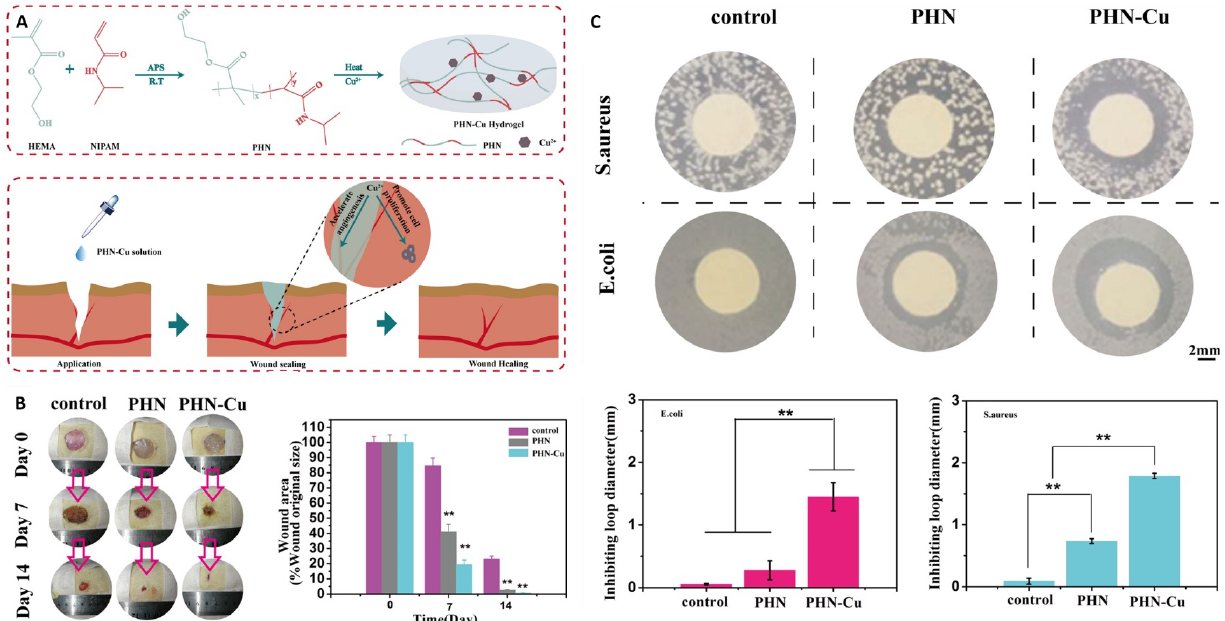
Figure 2. A schematic showing the preparation of thermosensitive polymer followed by wound healing ( A ); the in vivo results of different samples when they were applied on the wounds for 14 days ( B ); the antibacterial activity of samples against both Staphylococcus aureus and Escherichia coli bacteria ( C ); ammonium persulfate (APS), radical transformation (RT), poly-(HEMA-co-NIPAM) (PHN), reprinted from [11] with permission from Wiley. ** denotes p <